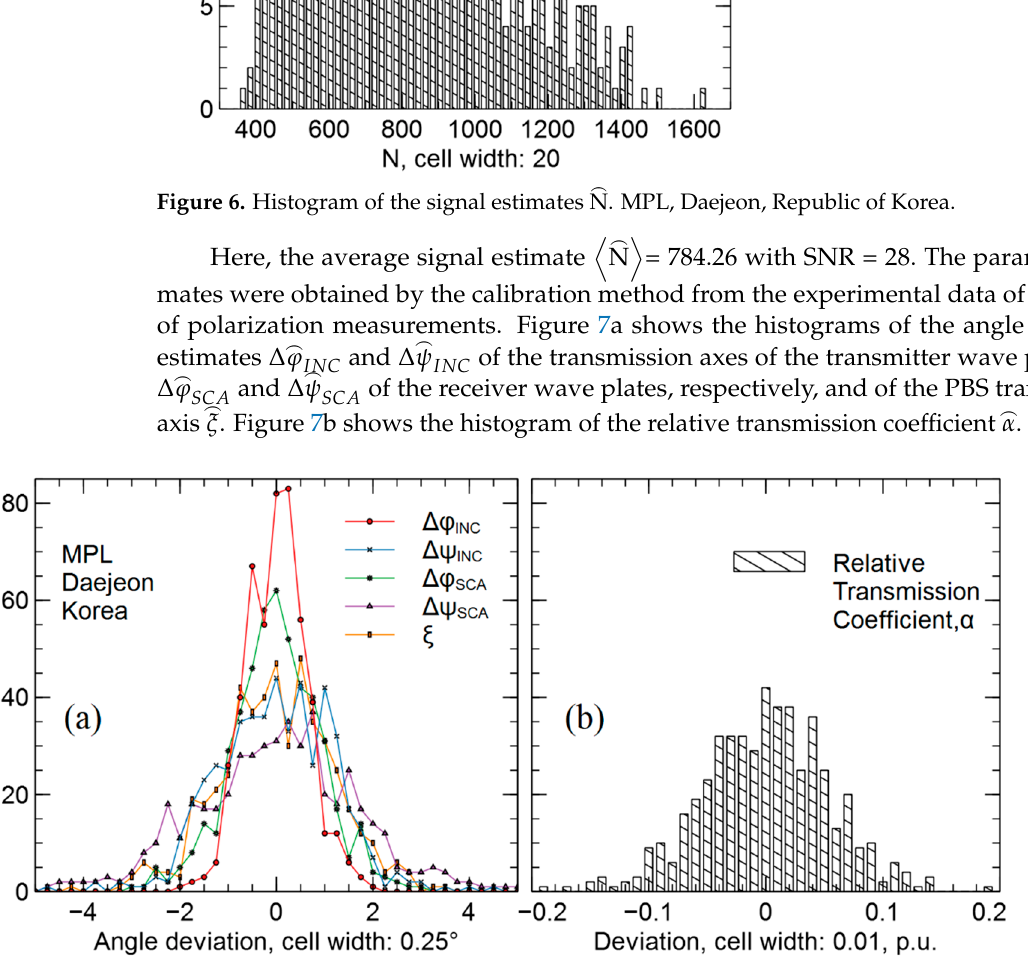
  Δ ) and receiver wave ψ Δ and > > > INC ϕ ψ ϕ and ∆ ) and receiver wave plates ( ∆   INC INC SCA Δ ) and receiver wave ψ Δ and > α . INC